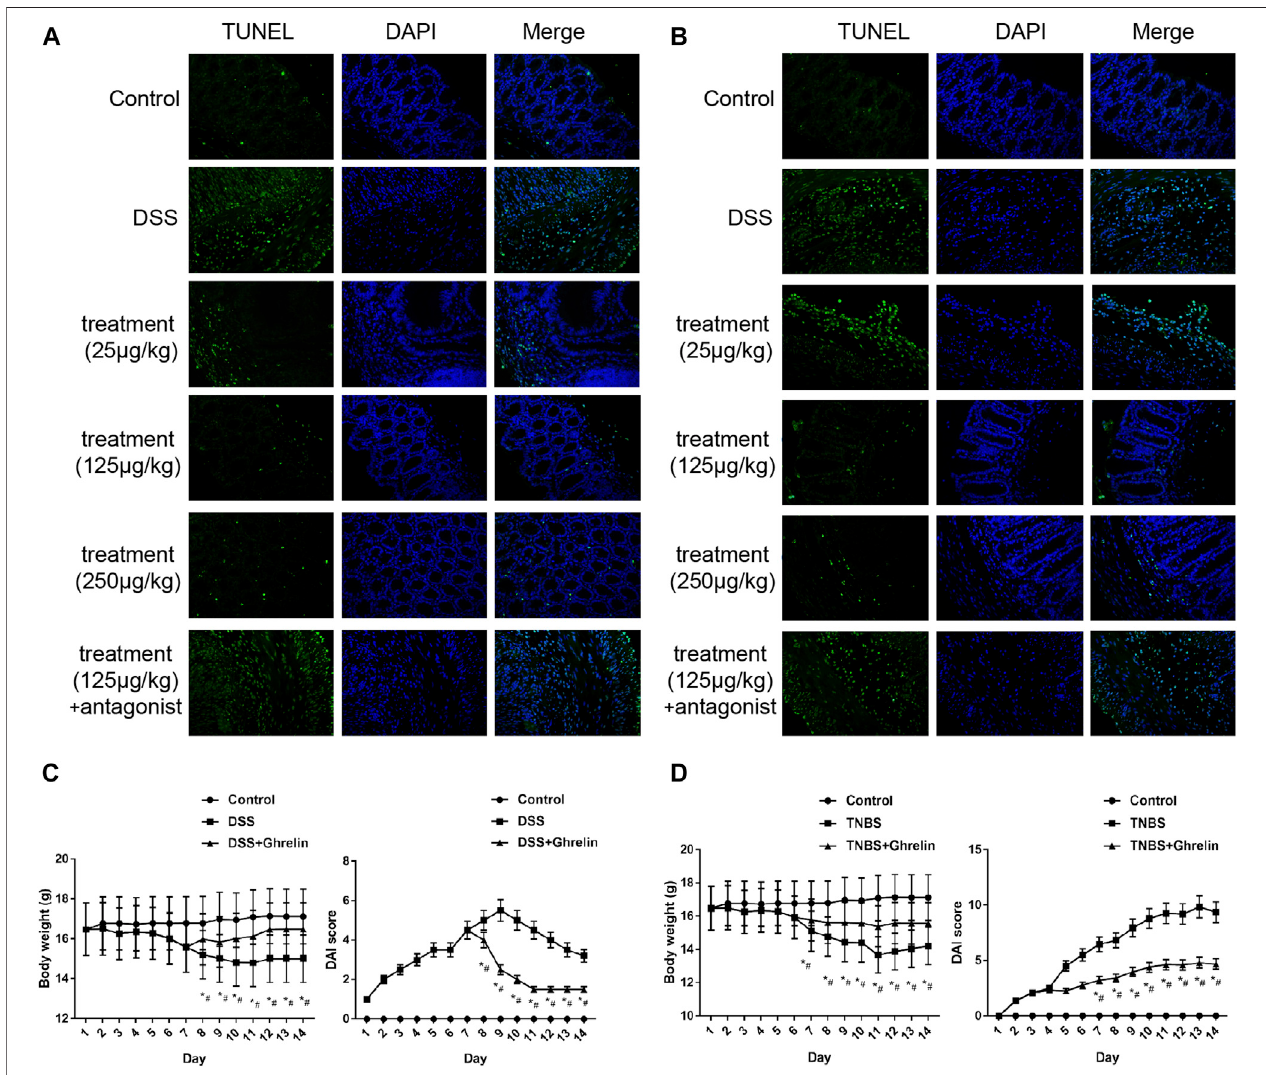
FIGURE 3 | Ghrelin reduced apoptosis in DSS- and TNBS-induced colitis in mice. (A) and (B) Antiapoptotic effects of ghrelin could be observed at 125 and 250 μ g/kgintheDSSmodelandat25,125,and250 μ g/kgintheTNBSmodel,andGHS-R1aantagonist[D-lys3]-GHRP-6abrogatedantiapoptoticeffectsofghrelin. C . Bodyweightand the DAI score in the DSS model group. D . Body weight and the DAI score in the TNBS model group. Representative blots from ten mice in each group were shown. * p < 0.05 DSS (or TNBS) vs. control, # p < 0.05 DSS (or TNBS) +Ghrelin vs. DSS (or TNBS).